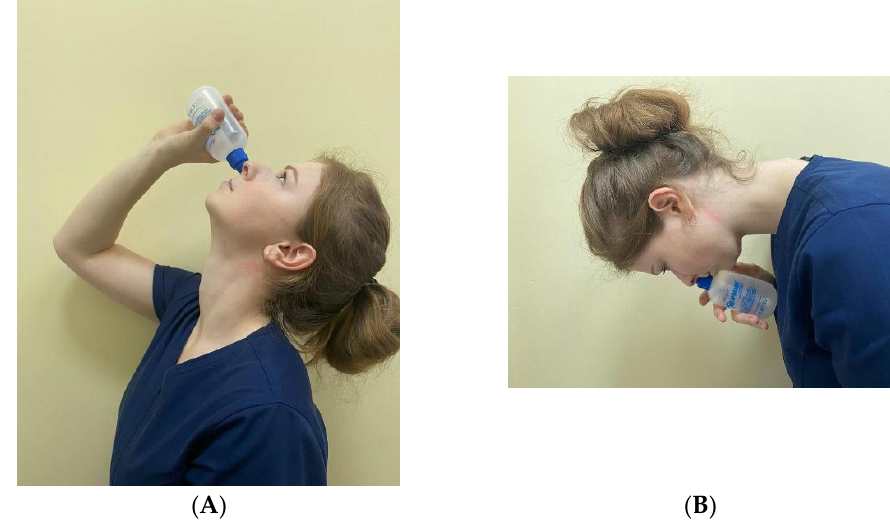
Figure 1. Example of the nose-to-ceiling ( A ) and nose-to-floor ( B ) head positions during the irrigation.